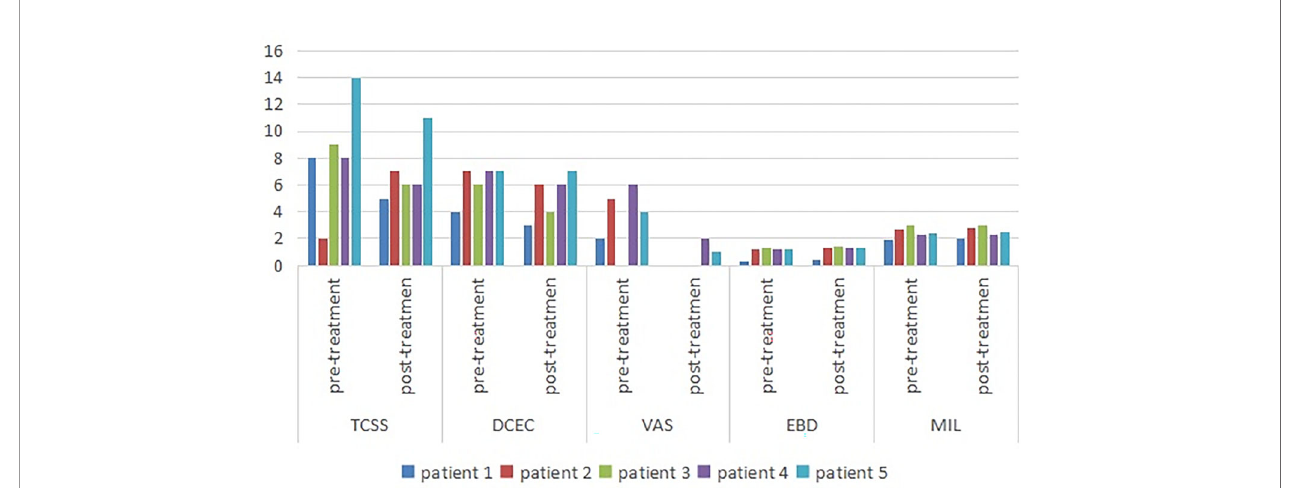
FIGURE 3 | Symptom scores and morphologic changes were compared at baseline and post-injection. Among symptom scores, the VAS was signi fi cantly decreased, as compared to baseline. The DCEC score of nerves was measured by ultrasonography at limbs. Compared with baseline, the DCEC score and TCSS score showed a signi fi cant decrease post-injection. The EDB and MIL were increased after ultrasound-guided injection. DCEC, de fi nition, cross sectional area, echogenicity and compression; TCSS, Toronto clinical scoring system; EDB, extensor digitorum brevis muscle; MIL, muscles of the fi rst interstitium; VAS, visual analogy